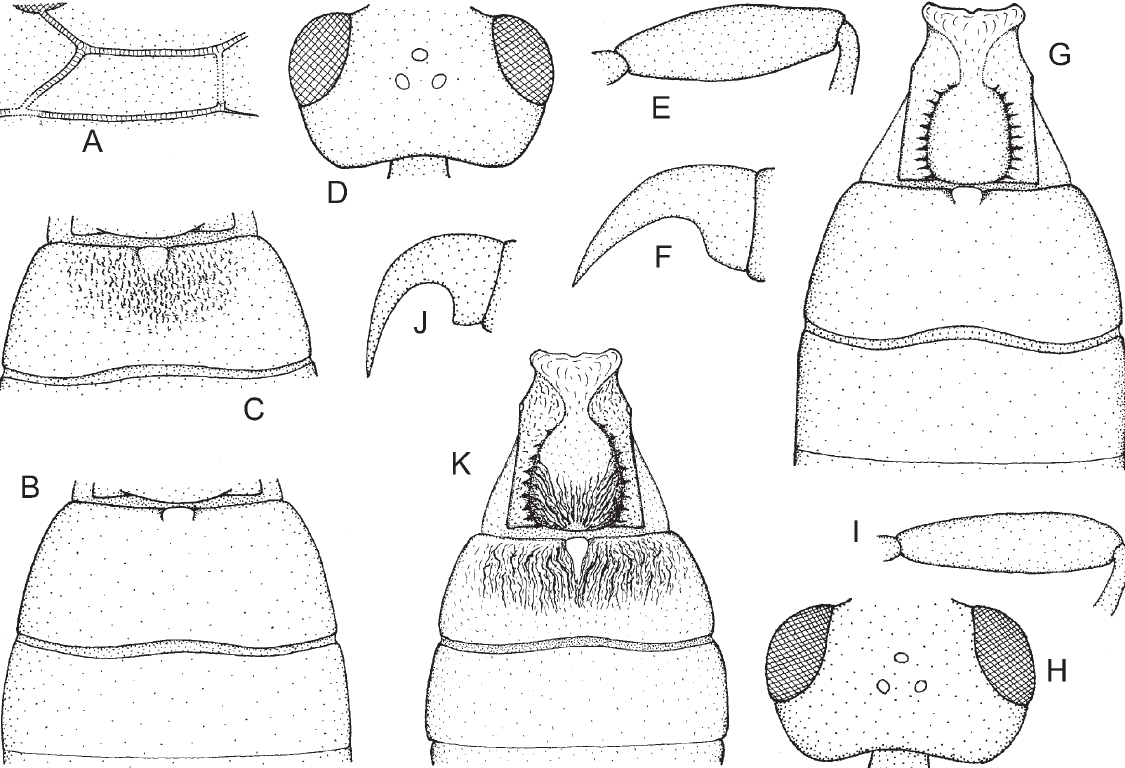
Fig. 6. — A-C . Bracon ( Glabrobracon ) discoideus Wesmael, 1838, ♀. A . Second submarginal cell of forewing. B . Tergites 2-3. C . Second tergite. — D-G . Bracon ( Glabrobracon ) batis Papp, 1981, ♀ holotype. D . Head in dorsal view. E . Hind femur. F . Claw. G . Tergites 1-3. — H-K . Bracon ( Glabrobracon ) epitriptus Marshall, 1885, ♀ paralectotype. H . Head in dorsal view. I . Hind femur. J . Claw. K .